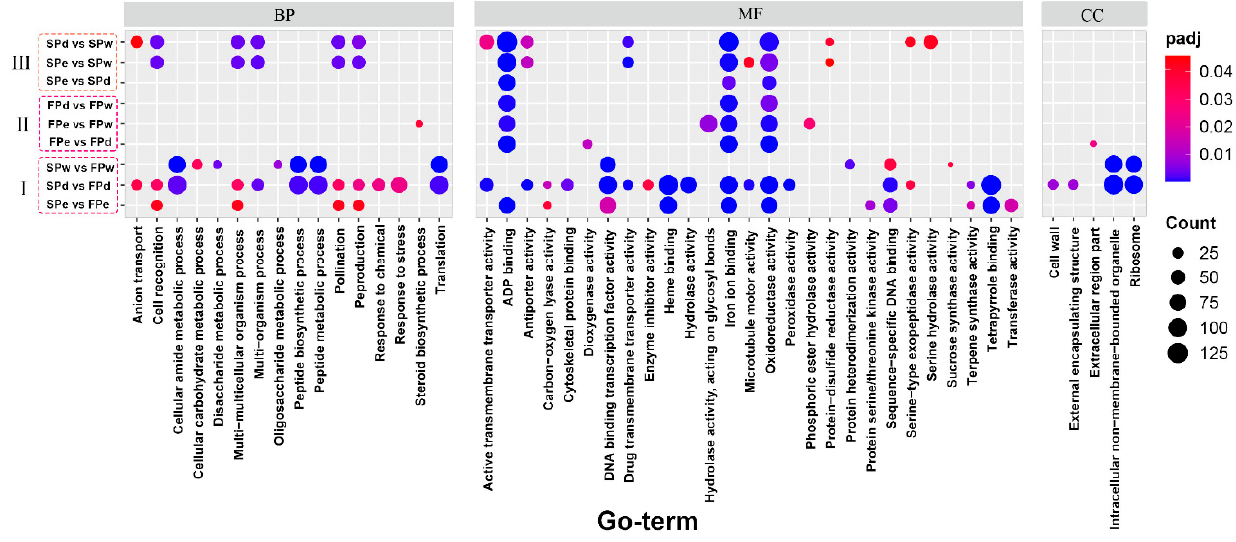
Figure 3. Gene Ontology (GO) enrichment analysis of DEGs in different comparisons. Group I within hybrids, group II under full sun, and group III under shade. Each node represents the enrichment result of the corresponding GO term in different comparisons. Node color and size indicate the P -value and number of DEGs showing enriched terms.